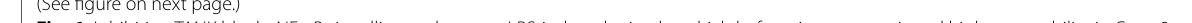
0.5 μm). Yellow arrows indicate the = SD. Each result was ±